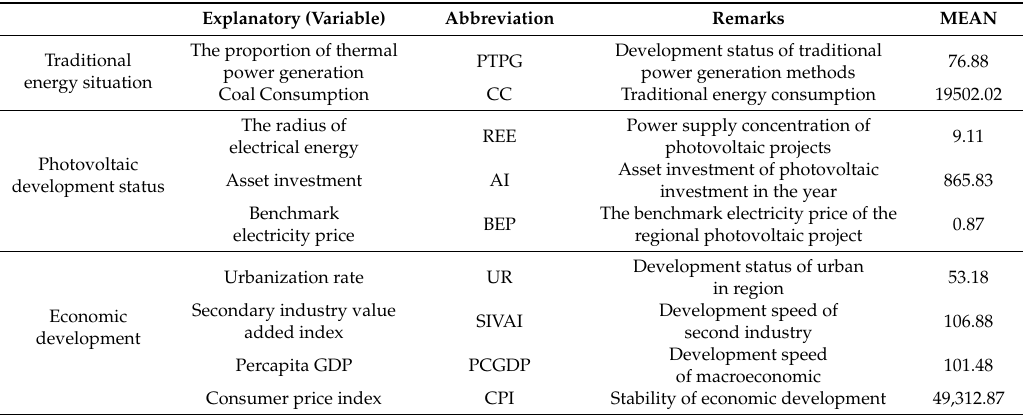
Table 2. Indicators for analysis of factors affecting